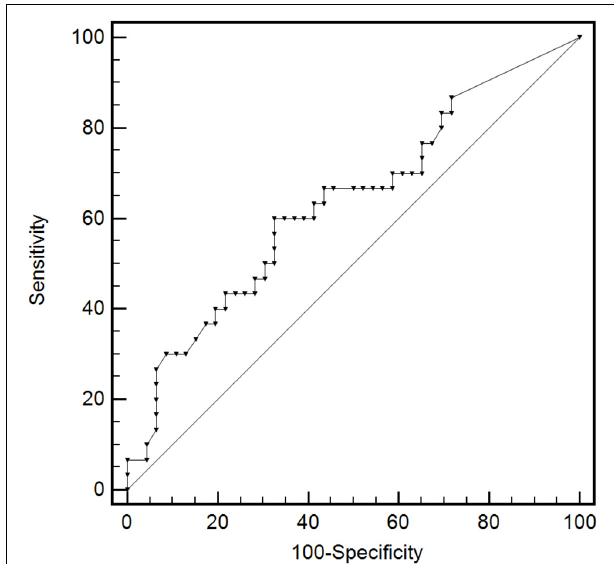
FIGURE 5 | The ROC curve of plasma BKPyV-DNA load for predicting BKPyV infection in proximal tubular epithelium. Receiver operator characteristic curve (ROC).